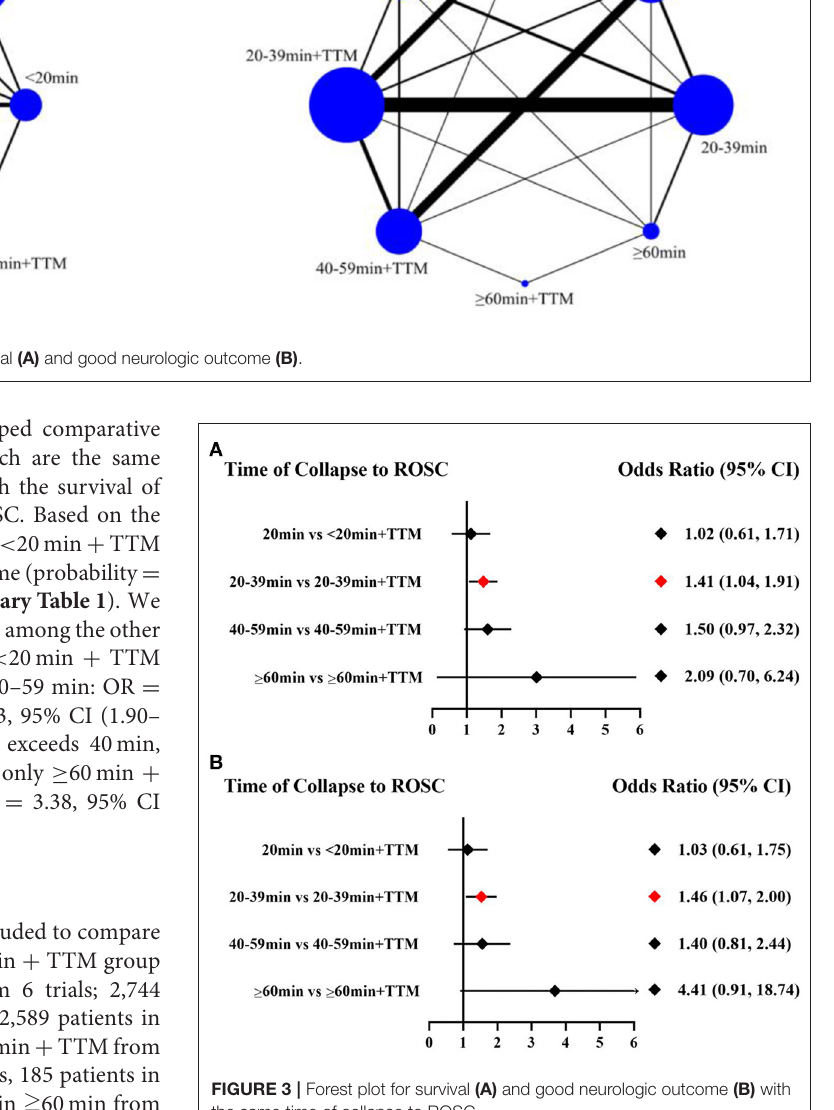
good neurologic outcome (probability = 52.5%, SUCRA